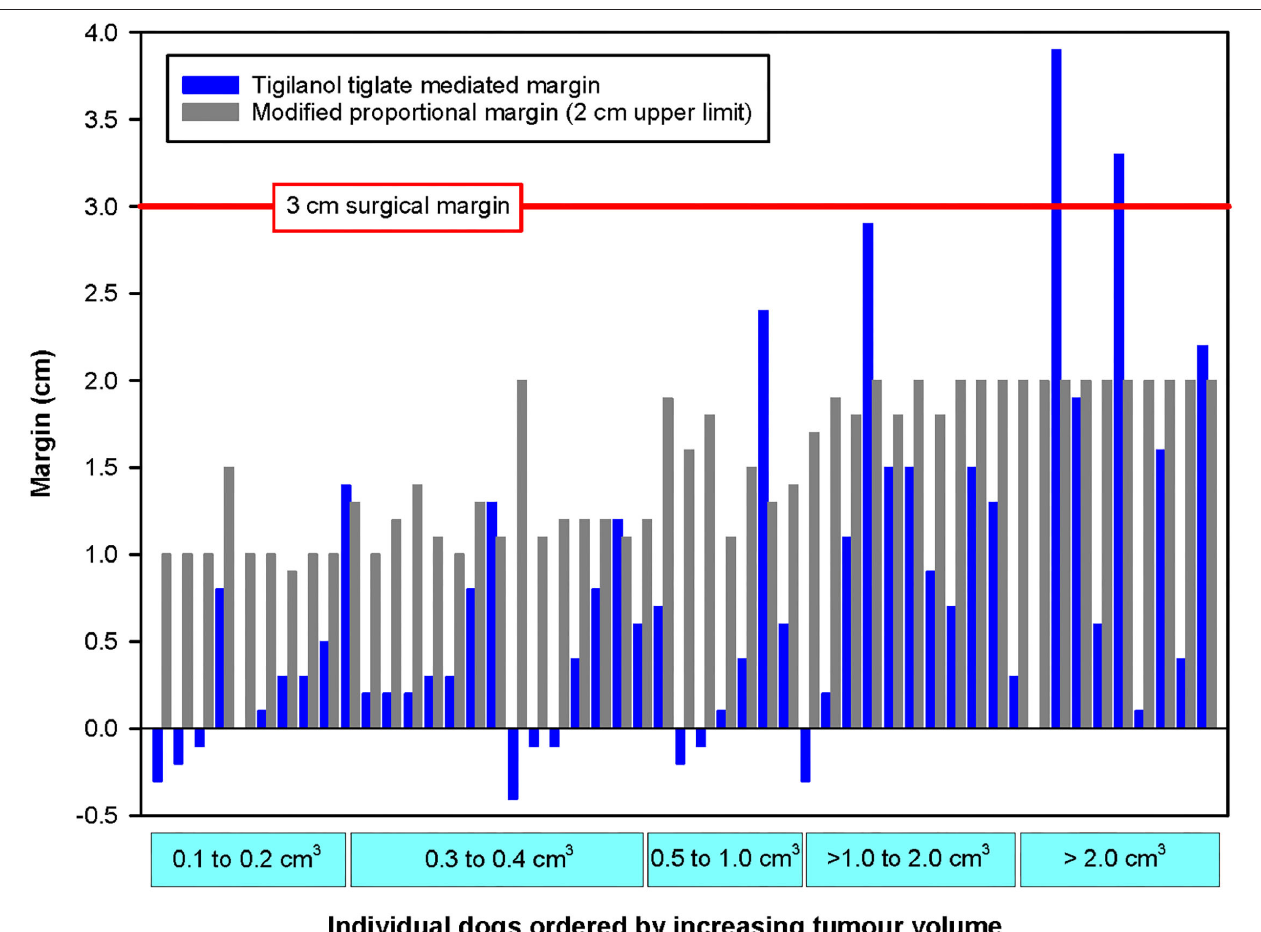
FIGURE 4 | Paired comparison of TT-mediated margins with modified proportional surgical margins organised by increasing tumour volume for each of the 51 dogs that were recurrence free 12 months after a single intratumoural treatment of an MCT with TT. The horizontal red line represents the 3cm surgical margin. Note that the small negative values for TT-mediated margins that were recorded for nine dogs are likely associated with minor inaccuracies in measurement of small tumours and/or small tissue deficits by the clinical